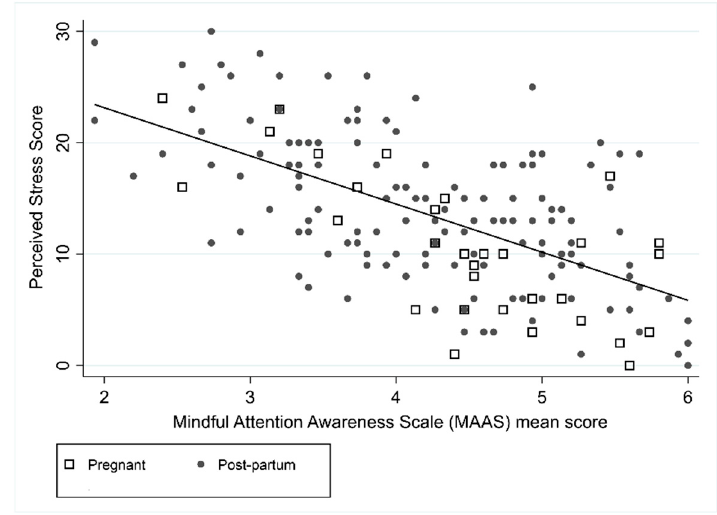
Figure 4. Association between PSS and MAAS. Table 2. Mental health (PSS and MHC) and its relationship with resilience (SCS and MAAS) and pregnancy using univar ‐ iable and multivariable regression.